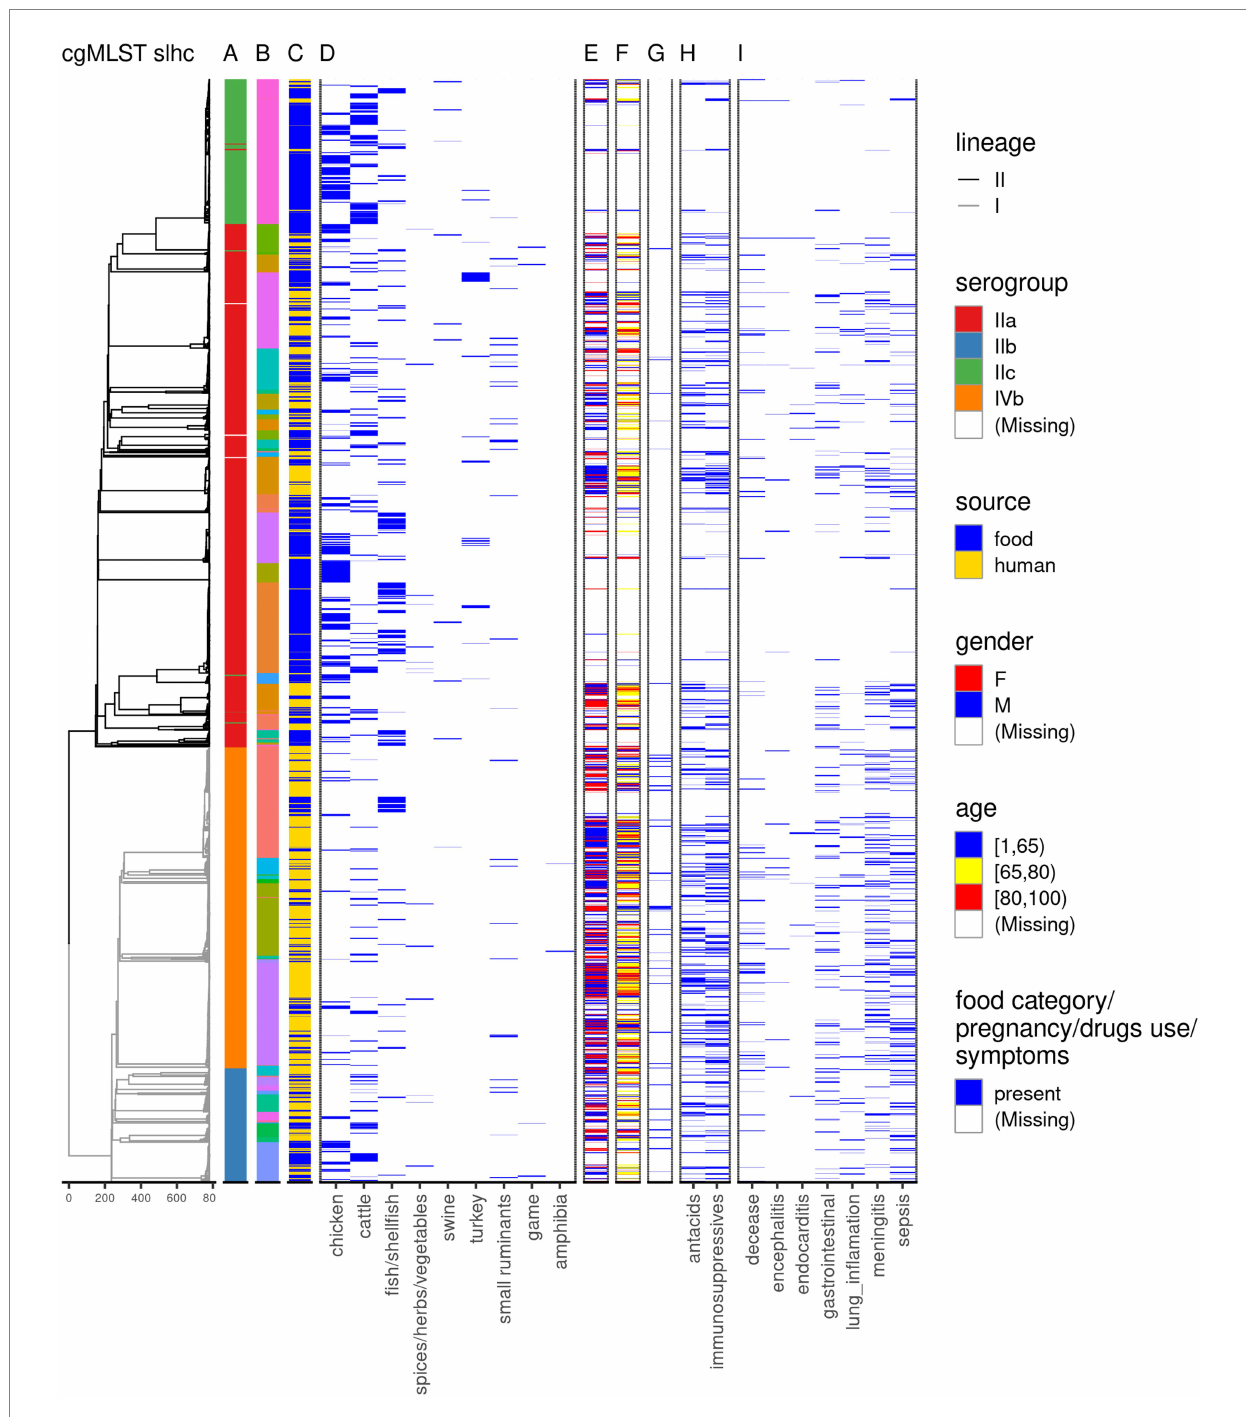
FIGURE 1 Overview of the dataset used in this study. The dendrogram is based on single linkage hierarchical clustering of cgMLST profiles of the isolates; the branches are colored by lineage. The annotation columns indicate the serogroup (A) , clonal complex–due to the large number of clonal complexes, these are not displayed in the legend, but can be found in Supplementary Table 1 (B) , source of the Lm sequences (C) , and food category (D) . For the human cases data on gender (E) , age (F) , pregnancy (G) , medicine use (H) , and symptoms following the Lm infection (I) is